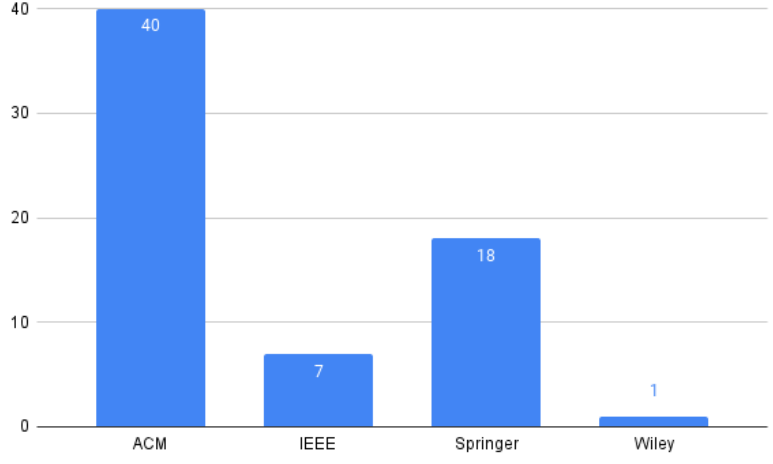
Figure 13. Number of papers according to